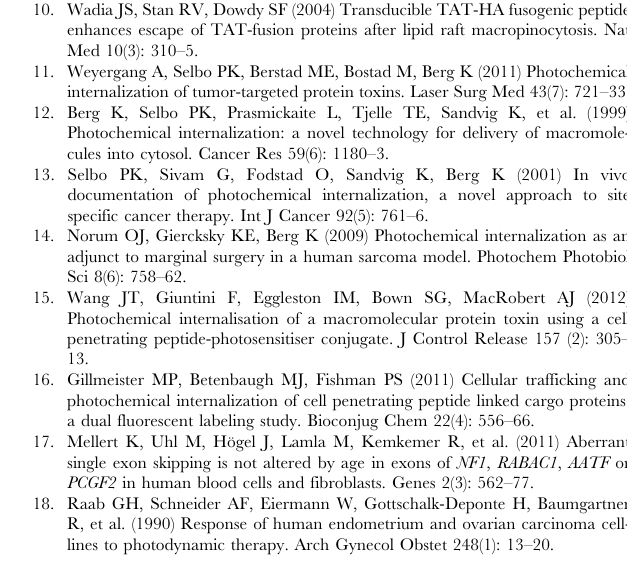
the phase contrast (PH), the fluorescence signals (FL) and the merged pictures (Merge). Figure S6 Punctuated protein localization in fibroblasts and neurofibrosarcoma cells detected by fluorescence microscopy. Phase contrast is shown in blue color, the Atto488 2 /FITC- signal in green color. (A) Primary fibroblasts (FP1) were Atto488-BSA transduced using the Proteoducin reagent. The signals are punctate with a predominated perinuclear location. (B) Transduction of a FITC-labeled anti-actin antibody into neurofibrosacoma cells produced comparable signals. Figure S7 b -galactosidase transduced cells show b -gal activity after PCI treatment. b -gal transduced, PCI treated neurofibrosarcoma cells are shown (A) in phase contrast and (B) as a bright field picture. Untransduced, PCI treated neurofibrosar- coma cells are given (C) in phase contrast and (D) as a bright field picture. All cells were stained for b -gal activity. The transduction was performed using the Chariot transduction reagent. The b -gal transduced and PCI treated cells show a clear b -gal activity (A + B) whereas no b -gal activity could be detected in the untransduced and PCI treated cells (C + D). (TIF) Movie S1 Live movie of the escape of the Atto488 signals in living cells. The movie shows the overcoming of endosomal entrapment during PCI treatment. Transduced and TPPS 4 treated sarcoma cells were illuminated using a FITC/GFP filter set. The light reaching the cells excites both the photosensitizer TPPS 4 and the Atto488. Therefore pictures could be taken throughout the whole PCI treatment. Single images were put together as an image sequence and converted into avi format. 1 second of the movie represents 6 seconds of the